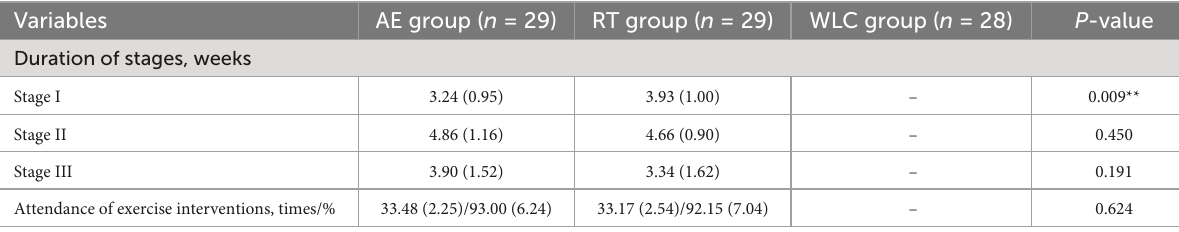
TABLE 4 The implementation of exercise intervention of the